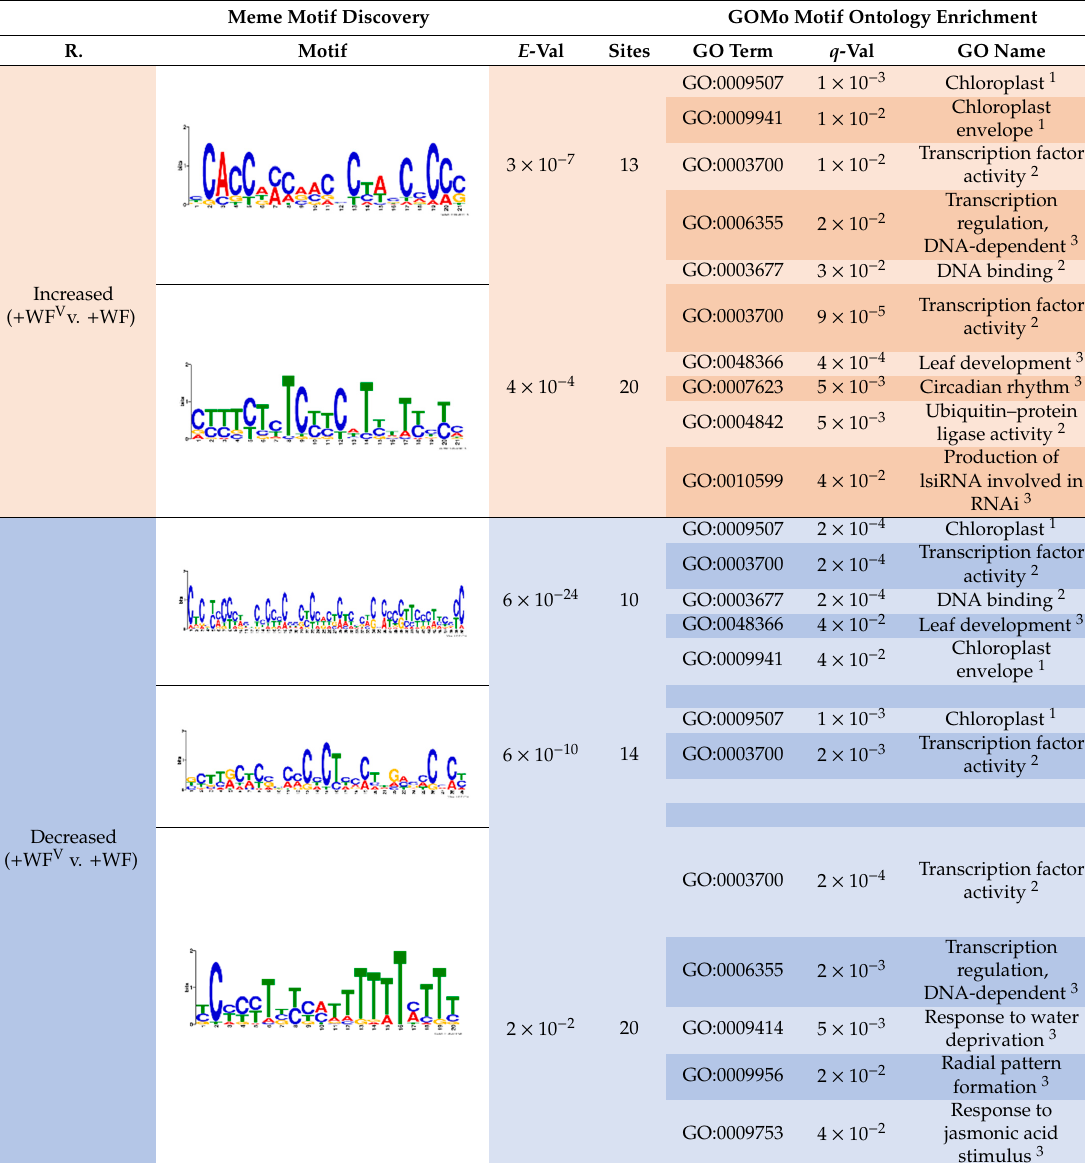
Table 2. Motif discovery and ontology enrichment analysis of similar motifs upstream of genes in Arabidopsis.